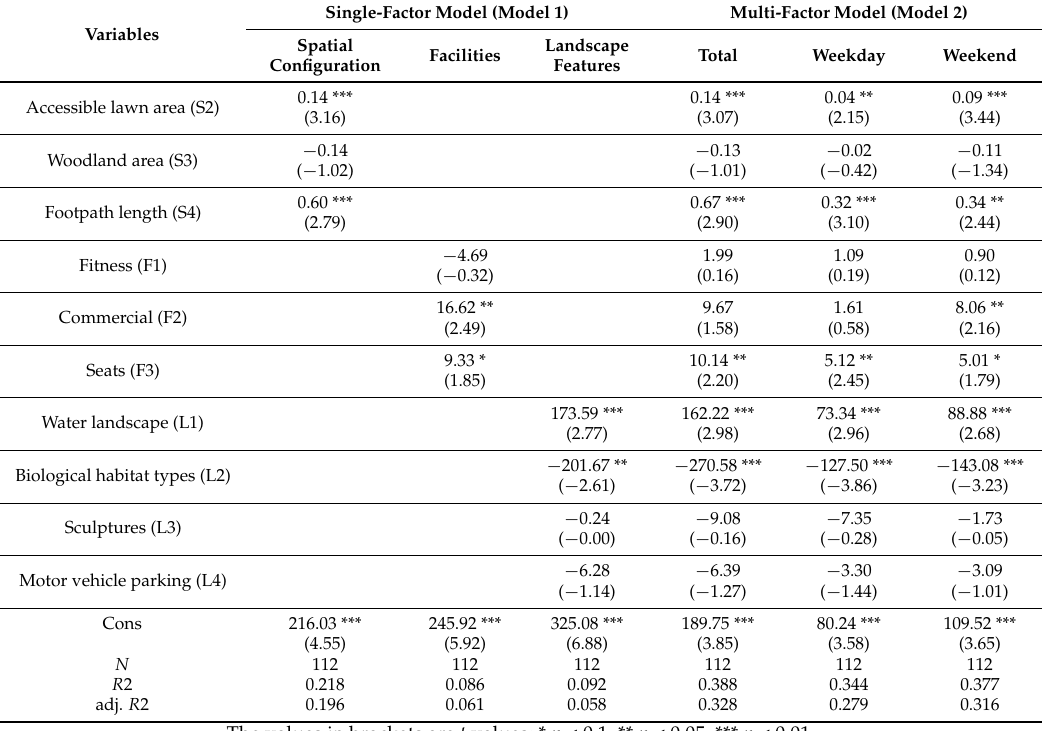
Table 3. Single-factor and multi-factor regression models.